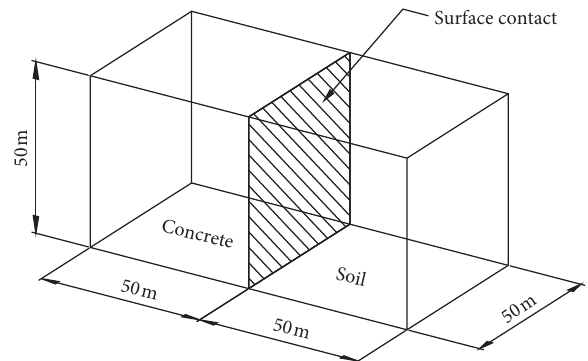
Figure 9: Dimensions of model 3.